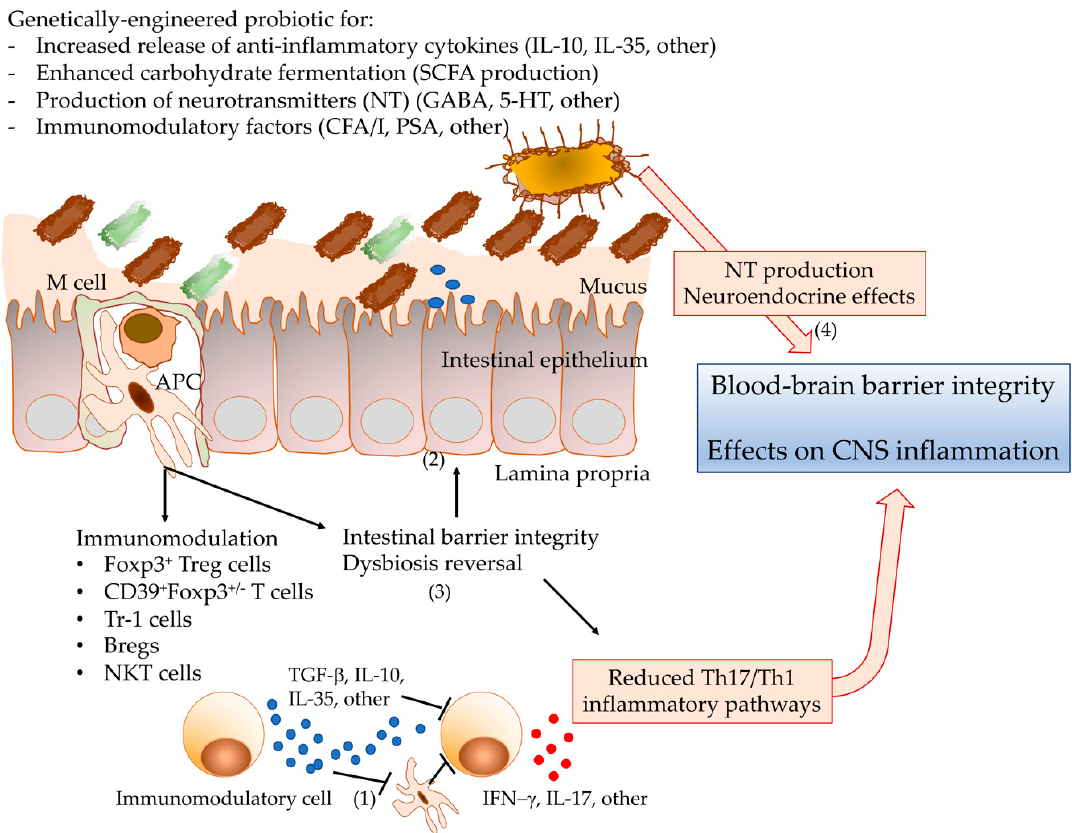
Figure 1. Potential mechanisms of action for neuroinflammation-targeting probiotics. Microbial factors, such as colonization factor antigen I (CFA/I) fimbriae or polysaccharide A (PSA), promote the differentiation of immunoregulatory cell subpopulations. Modifications of the balance between inflammatory and immunoregulatory cells by inhibitory effects on antigen presenting cells (APCs), or directly targeting proinflammatory cell populations with anti-inflammatory cytokines (1) suppress experimental inflammatory demyelination. Microbial metabolites, such as SCFA, can also regulate the integrity of the intestinal barrier as well as the blood–brain barrier (2). Probiotics have also been shown to restore intestinal homeostasis by balancing the microbiota (3). Furthermore, the design of probiotics specifically directed to increase the production of other metabolites, such as neurotransmitters, could affect the neurobiology of CNS inflammatory diseases (4). APC: antigen presenting cell; Breg: regulatory B cell; CFA/I: colonization factor antigen I of enteroxigenic Escherichia coli; CSFA: short-chain fatty acids; CNS: central nervous system; 5-HT: 5- hydroxytryptamine (5-HT); IL: interleukin; IFN: interferon; NKT: natural killer T cell; PSA: polysaccharide A; TGF: transforming growth factor.